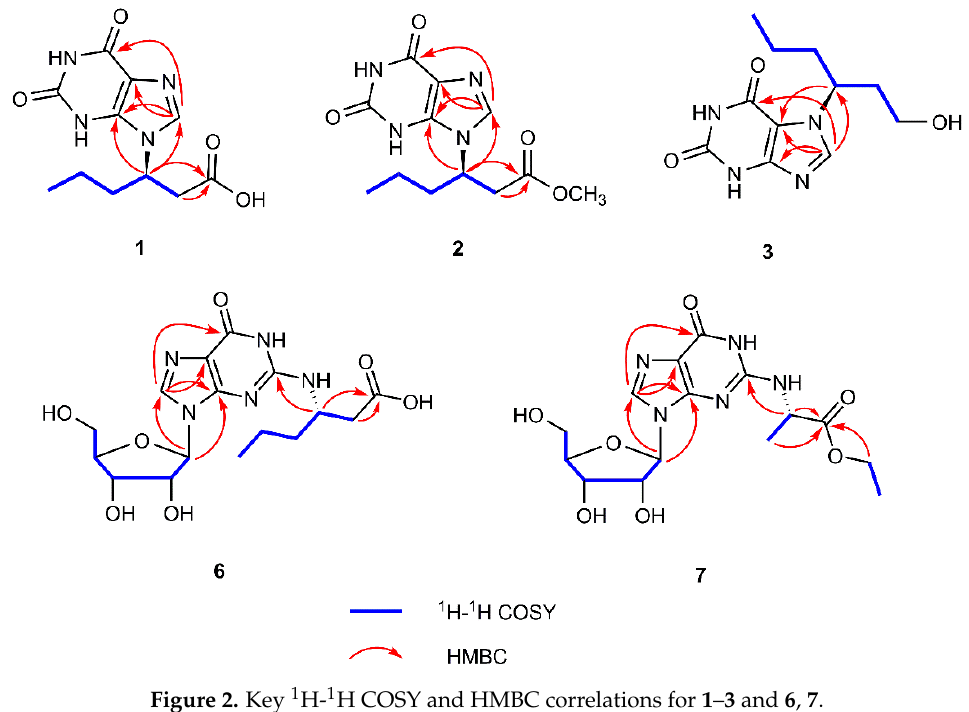
Figure 2. Key 1 H- 1 H COSY and HMBC correlations for 1 – 3 and 6 , 7 .